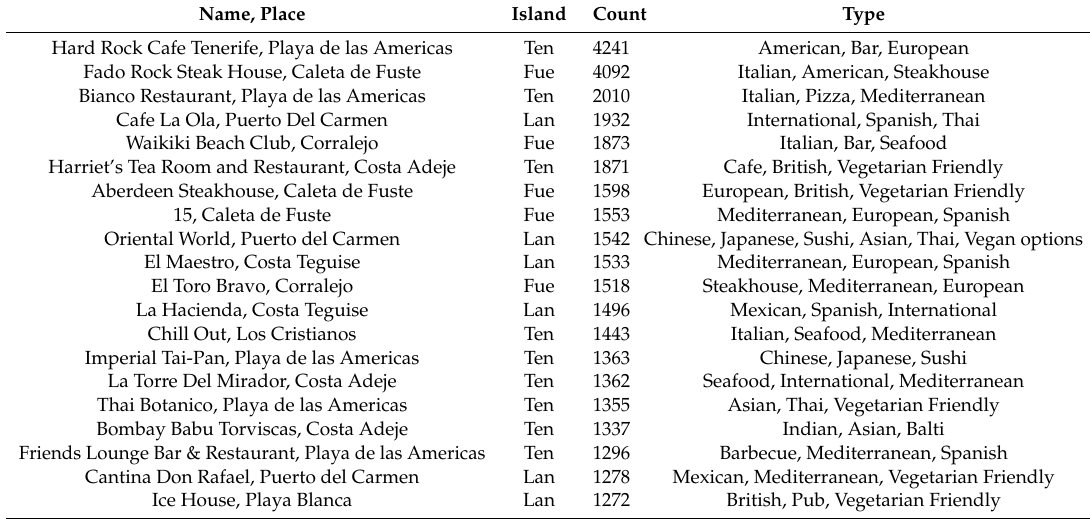
Table 6. Top 20 Canary Islands establishments serving food by number of online travel reviews. Name, Place